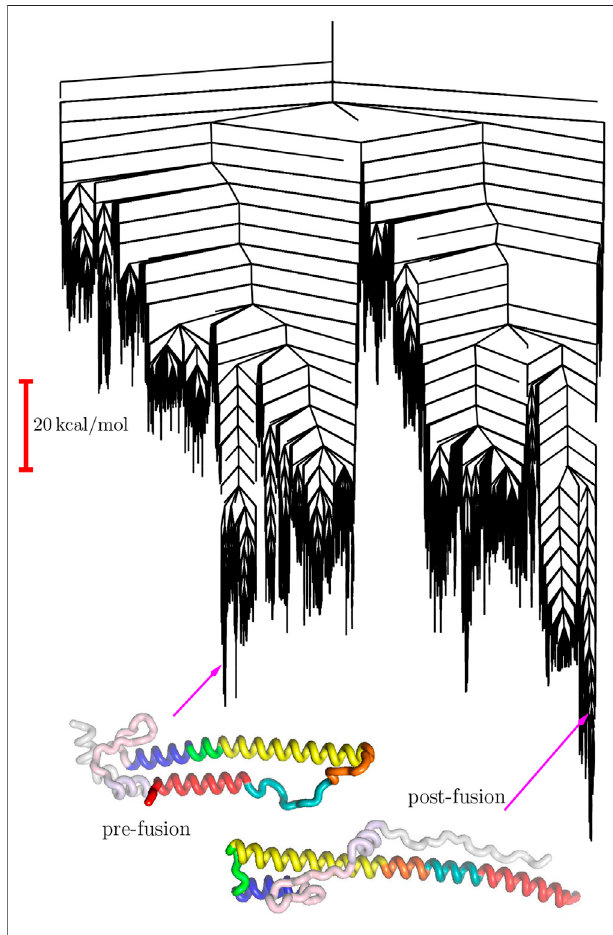
FIGURE 1 | Disconnectivity graph for the HA2 system marking the locations of the pre-fusion and post-fusion minima (Burke et al.,